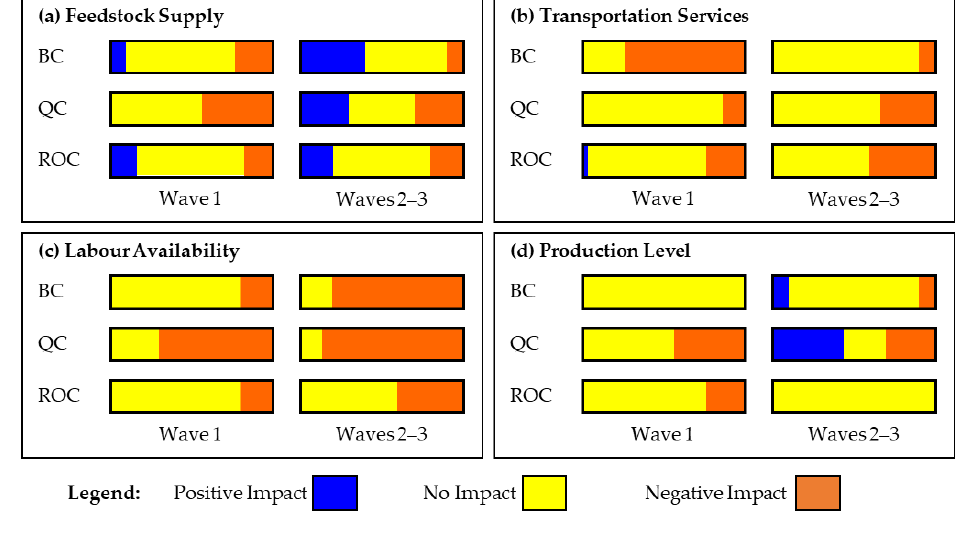
Figure 6. Survey results summary dashboard.